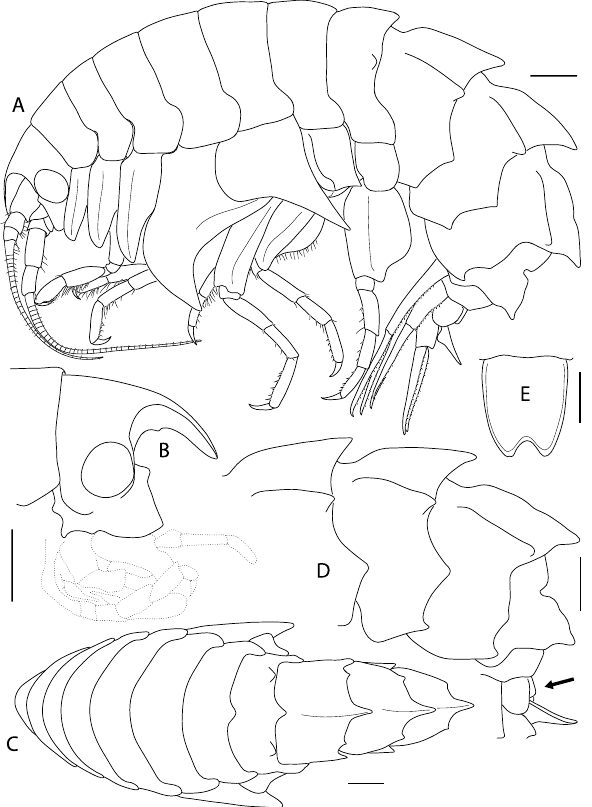
Figure 14. Epimeria cornigera , neotype, adult female, northern North Sea, NHMUK 2015.3268: ( A ) lateral habitus, ( B ) head in lateral view, ( C ) dorsal habitus, ( D ) pleon and urosome, ( E ) telson; scales: (A,B,C,D) 1 mm; (E) 0.5